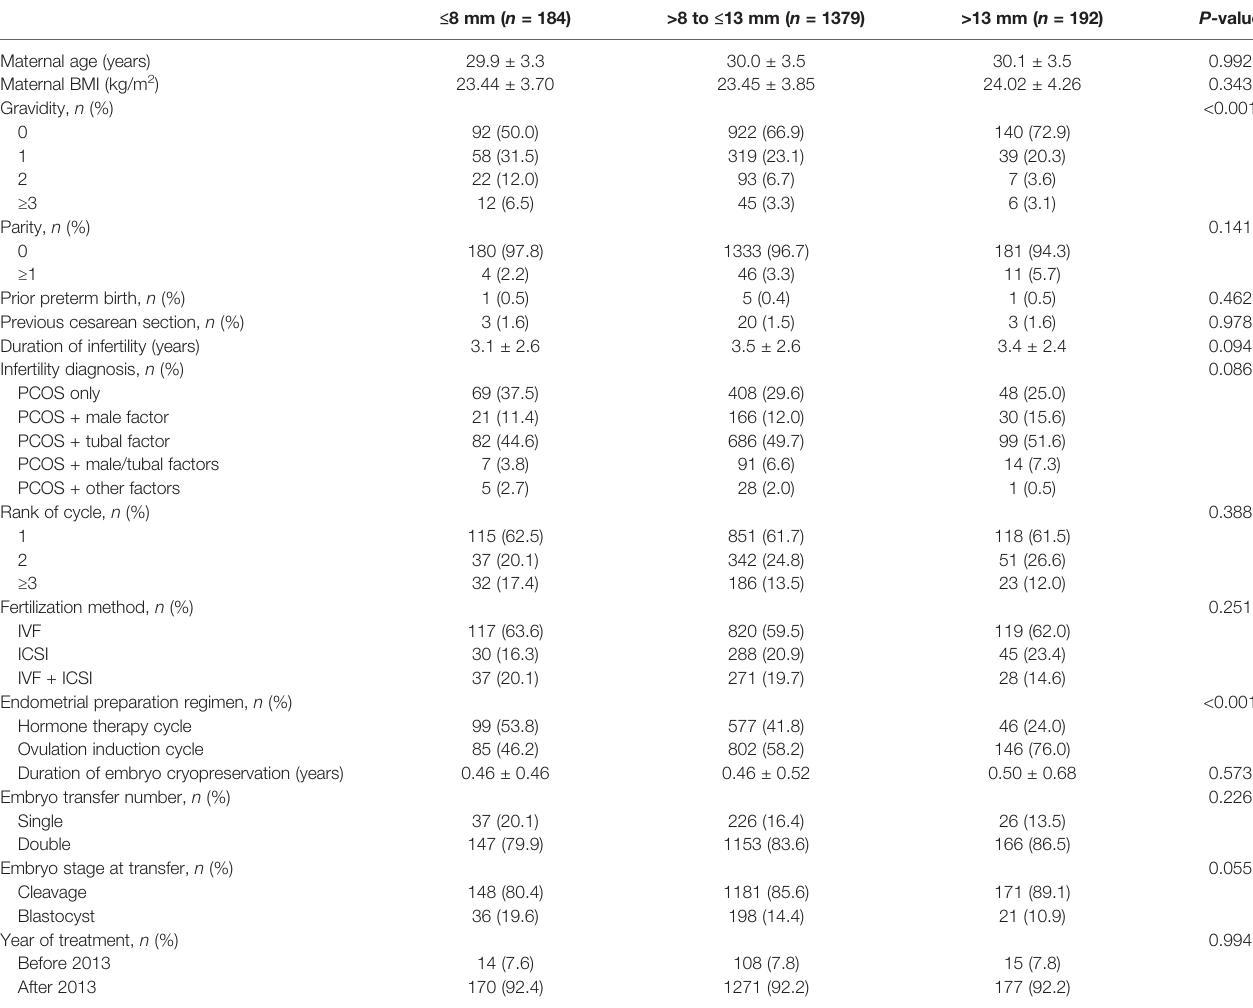
TABLE 1 | Baseline demographics and cycle characteristics grouped by endometrial